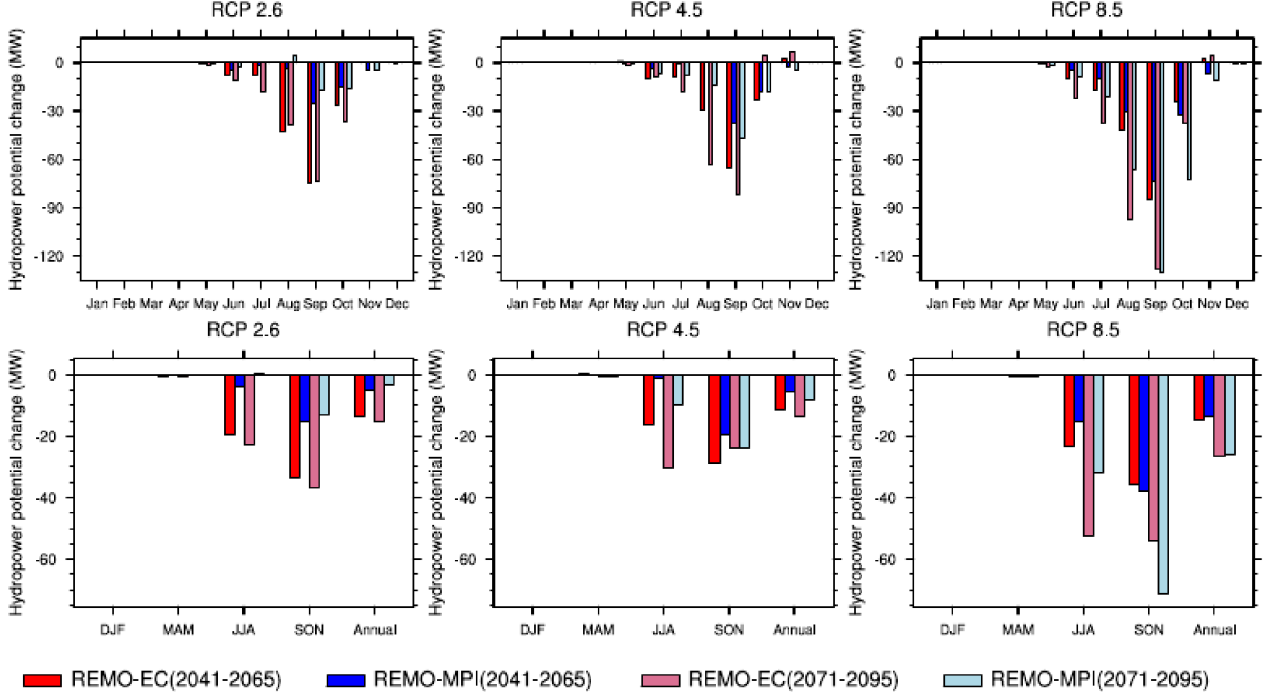
Figure 3. Projected monthly (top), seasonal and annual (bottom) changes in hydropower potential of the Lagdo dam under the three scenarios (RCP2.6, RCP4.5, RCP8.5) for the two future periods (2041–2065 and 2071–2095) relative to the baseline period (1981–2005).